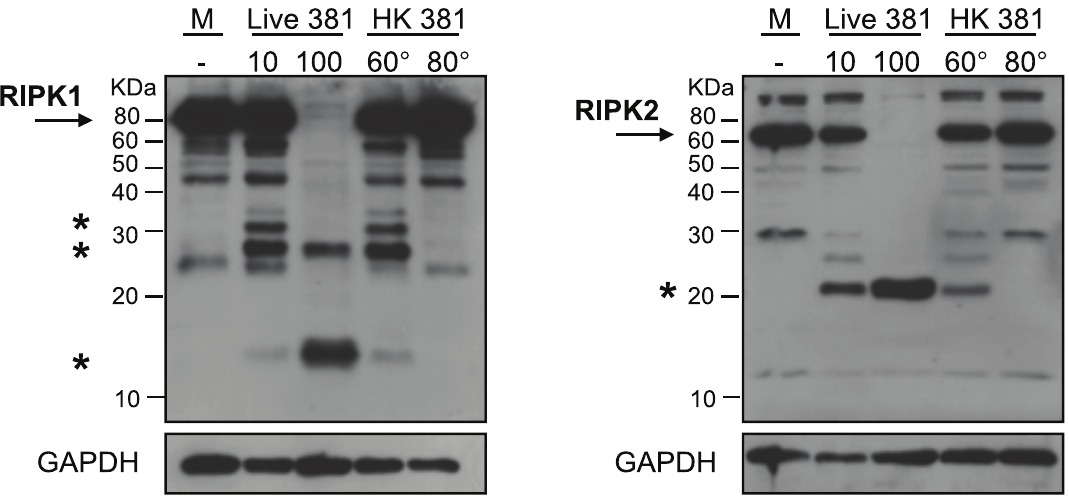
Figure 2. P.gingivalis -induced proteolysis of RIPK proteins is dose-dependent and heat labile. HAEC were treated with medium ( M ), live P. gingivalis strain 381 (MOI 10) ( 10 ), live P. gingivalis (MOI 100) ( 100 ), heat-killed (HK) (60 u C, 60 min) P. gingivalis 381 (MOI 100 equivalency) ( 60 6 ), or with HK (80 u C, 20 min) P. gingivalis 381 (MOI 100 equivalency) ( 80 6 ) for 2 h. Whole cell lysates were analyzed for the detection of RIPK1 (left panel) or RIPK2 (right panel). Full-length RIPK1 and RIPK2 are indicated with arrows. Prominent P. gingivalis -induced LMW bands are indicated with asterisk(s). MW ladder is indicated on the left in kDa. GAPDH was detected as a loading control.